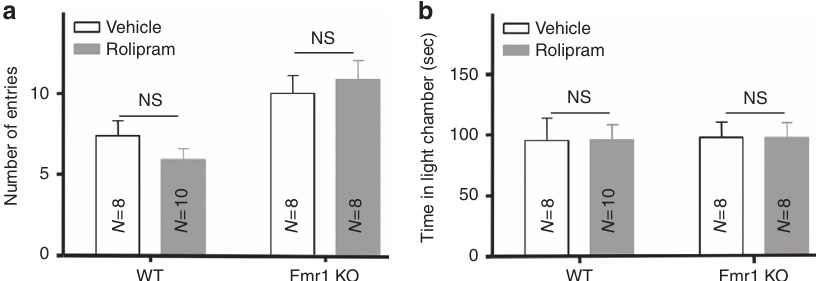
Figure 6 | Acute pharmacological inhibition of PDE has no significant effect on the FXS-associated phenotype in light/dark test. WTand Fmr1 KO mice received i.p. injection of rolipram (0.5mgkg (cid:2) 1 ) or vehicle. Thirty minutes after injection, mice were examined by light/dark test as described in Fig. 4. Regardless of treatment, Fmr1 KO mice showed more transition between the lit and dark chamber than WTmice (genotype effect: F 1,30 ¼ 15.2, P ¼ 0.001. two-way ANOVA) ( a ), and normal time in the lit chamber ( b ). Rolipram does not cause significant behavioural changes in either WT or Fmr1 KO mice (drug effect: F 1,30 ¼ 0.095, P ¼ 0.76, two-way ANOVA). NS: not significant. The numbers of animals for each group are indicated in the figure. Data are presented as mean ± s.e.m.